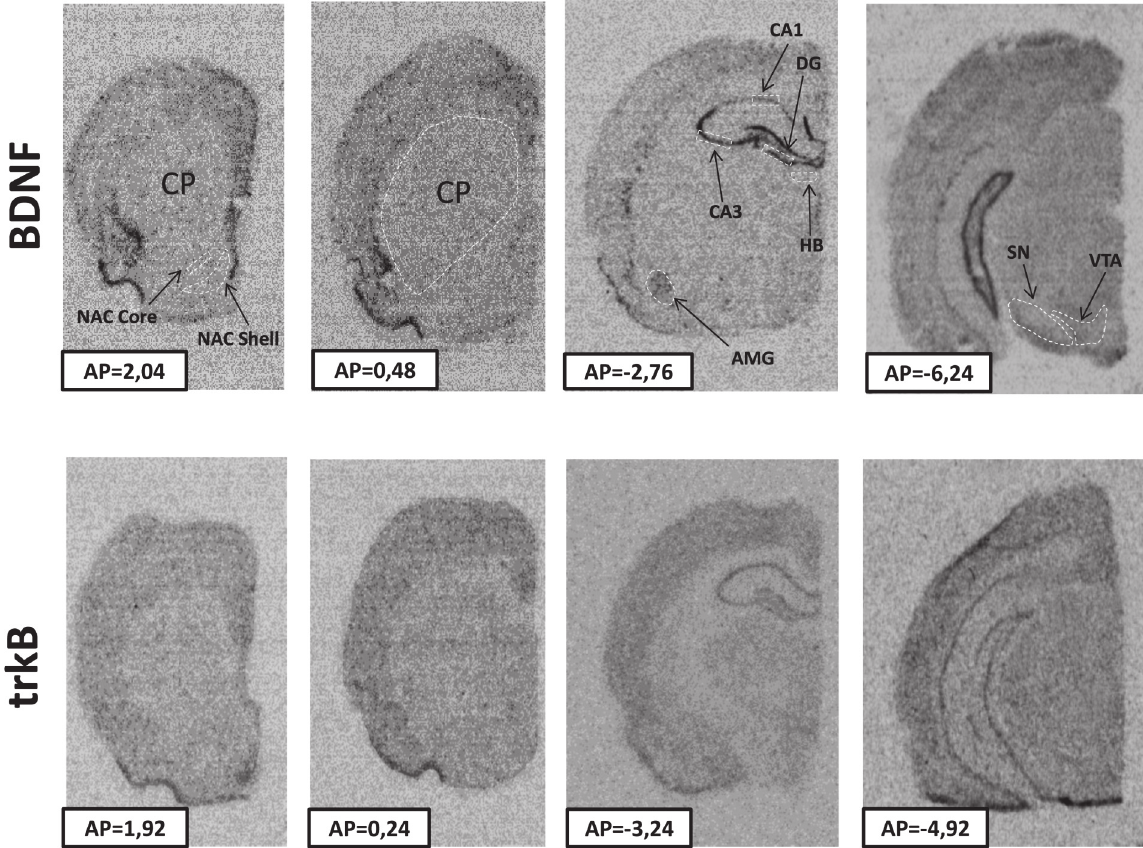
Fig 1. Representative autoradiograms showing BDNF and trkB mRNAs expression in frontal sections of the brain. Regions of interest are outlined. AMG — amygdala, CP — caudate-putamen, DG — dentate gyrus, HB — habenula, NAC — nucleus accumbens, SN — substantia nigra, VTA — ventral tegmental area. AP — anterior-posterior levels according to Paxinos and Watson